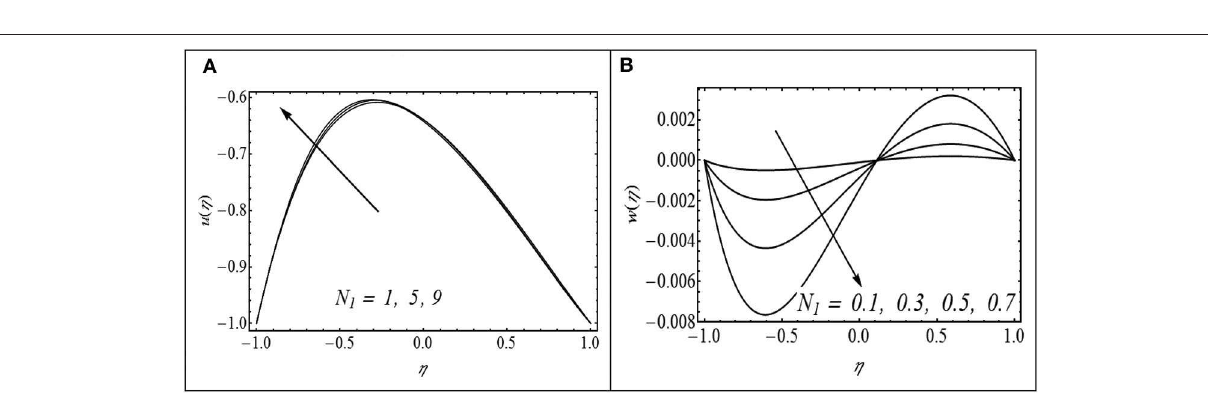
FIGURE 2 | (A,B) Impact of Ha on u (η) with γ = 2.5, N 1 = 0.5, N 2 = 1.2, λ = 0.4, and 2 = 1.5. (B) Impact of Ha on w (η) with γ = 2.5, N 1 = 0.5, N 2 = 1.2, λ = 0.4, and 2 = 1.5.